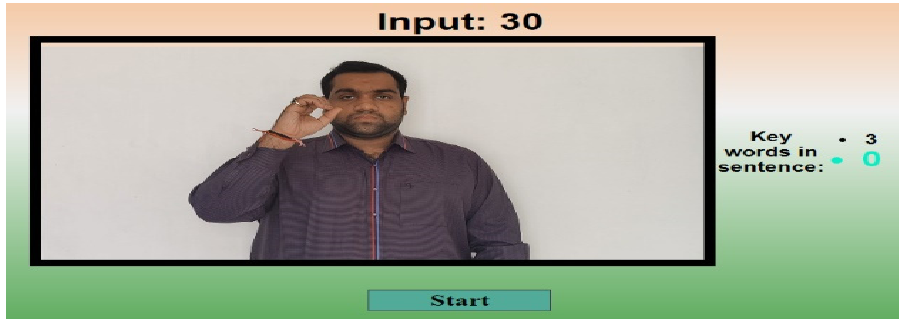
Figure 18. Case 8. Available video for number ‘0’.